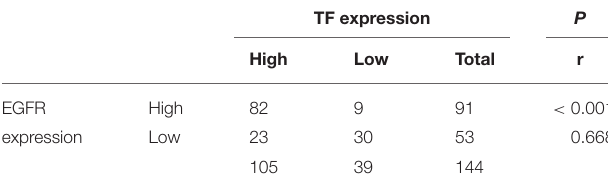
TABLE 1 | The correlation between TF and EGFR protein expressions in HCC tissues.